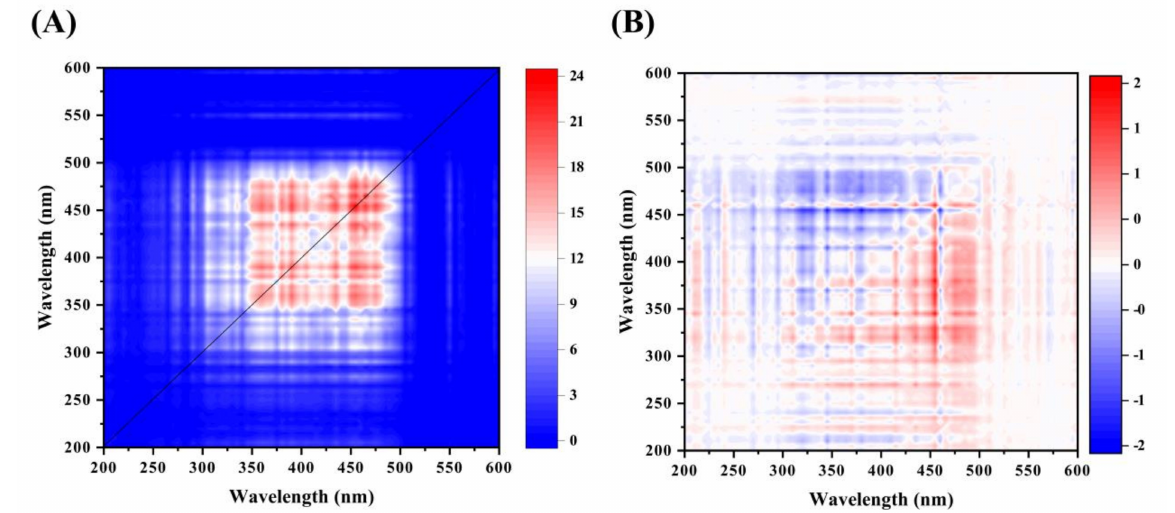
Figure 3. Synchronous ( A ) and asynchronous ( B ) 2D correlation maps generated from the synchronous fluorescence spectra of PA-derived